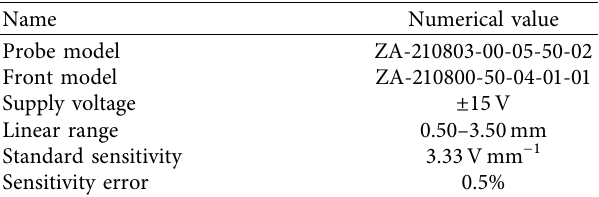
Table 9: Eddy current displacement sensor parameters.